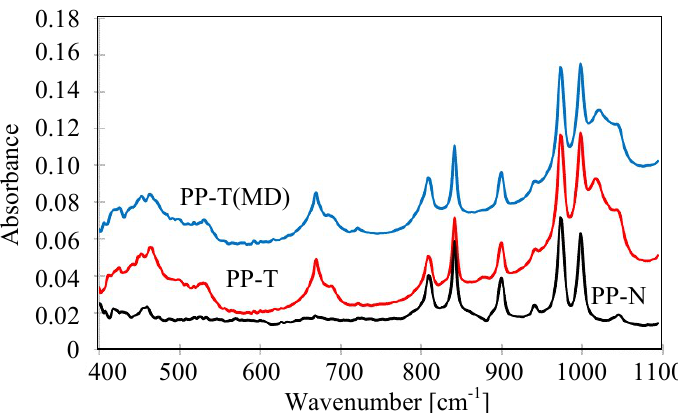
Figure 13. The results of FTIR analysis—peaks characteristic for talc. PP-T(MD) membrane sample colected from MD module after 350 h of the MD process.